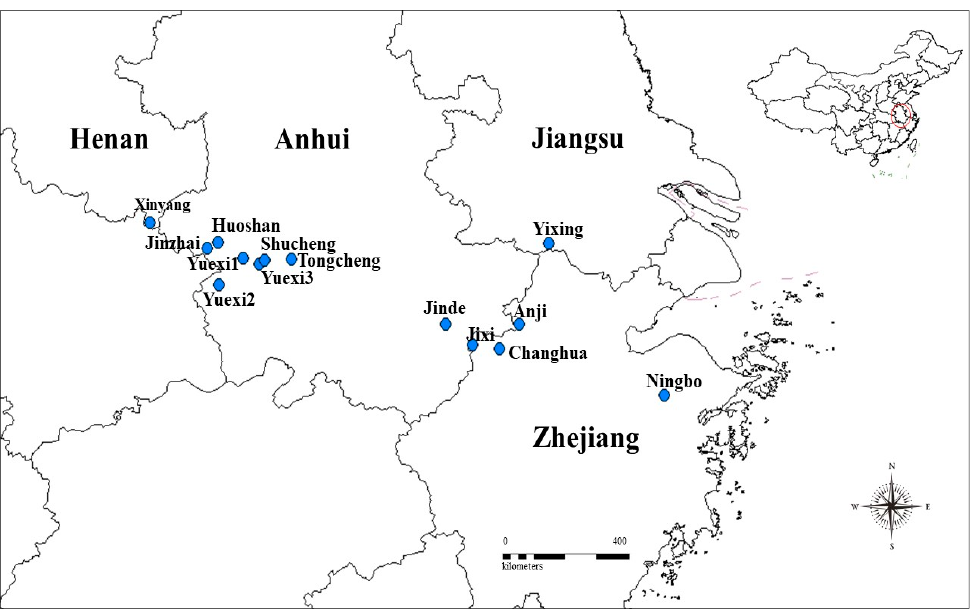
Figure 1. Distribution map of the sample Parrotia subaequalis (H. T. Chang) R. M. Hao et H. T. Wei populations across eastern China in 2016. The blue circles represent the extant population sites.